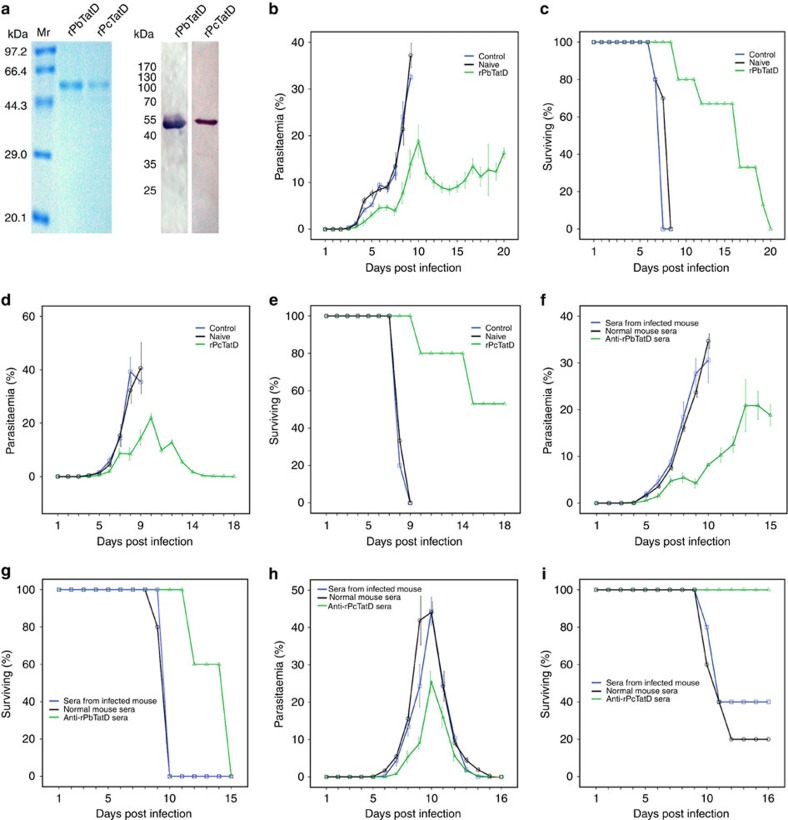
Immunization with the TatD-like DNase generates protective immunity against rodent malaria.(a) rPbTatD-HIS and rPcTatD-HIS were purified by affinity chromatography using His GraviTrap. The SDS–PAGE and western blotting assays revealed that the recombinant proteins were >90% pure. (b) BALB/c mice immunized with Freund's adjuvant alone or without any immunization (Naive) exhibited 3.12-fold higher parasitaemia than the rPbTatD-immunized group on day 11 post infection; the error bars indicate the s.d. (c) Mice in the rPbTatD-immunized group survived 10 days longer than the two control groups. (d,e) BALB/c mice immunized with Freund's adjuvant alone and naive mice exhibited 4.66-fold higher parasitaemia than the rPcTatD-immunized group on day 8 post challenge; the error bars indicate the s.d. All of the mice that received Freund's adjuvant alone and the naive group died on day 9 post infection; however, eight of the mice in the rPbTatD-immunized group were completely protected. (f,g) The group that received serum from a previously infected mouse exhibited 3.97-fold higher parasitaemia than the group that received anti-rPbTatD serum on day 10 post infection. Compared with the other groups, the group that received anti-rPbTatD serum survived for 5 days longer; the error bars indicate the s.d. (h,i) The group that received serum from a previously infected mouse exhibited 1.79-fold higher parasitaemia than the group that received rPcTatD-specific serum on day 10 post infection. The mice that received rPcTatD-specific serum showed a 100% survival rate. The error bars indicate the s.d.